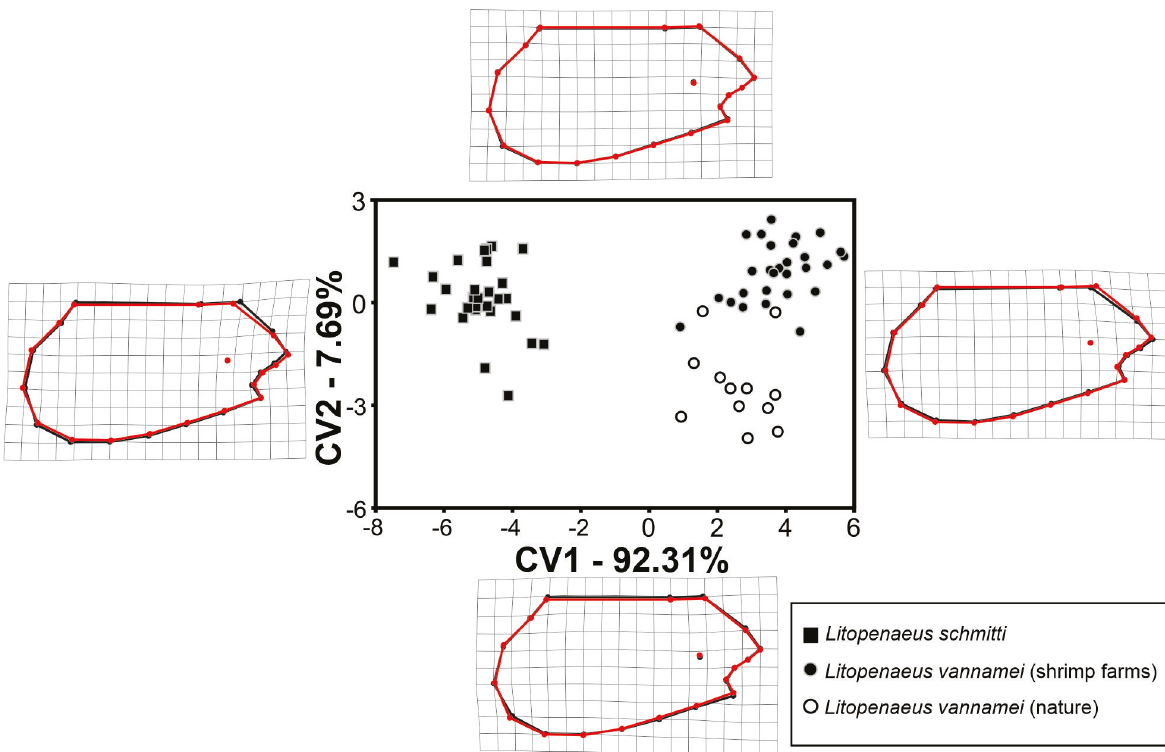
Figure 2. Canonical variable analysis of the ‘species’ ( Litopenaeus schmitti and Litopenaeus vannamei ) vs. ‘origin’ (nature and shrimp farms) factors as grouping factors and the deformation grids and shape wireframes for each investigated componente. Red = L. schmitti ; Black = L.s vannamei